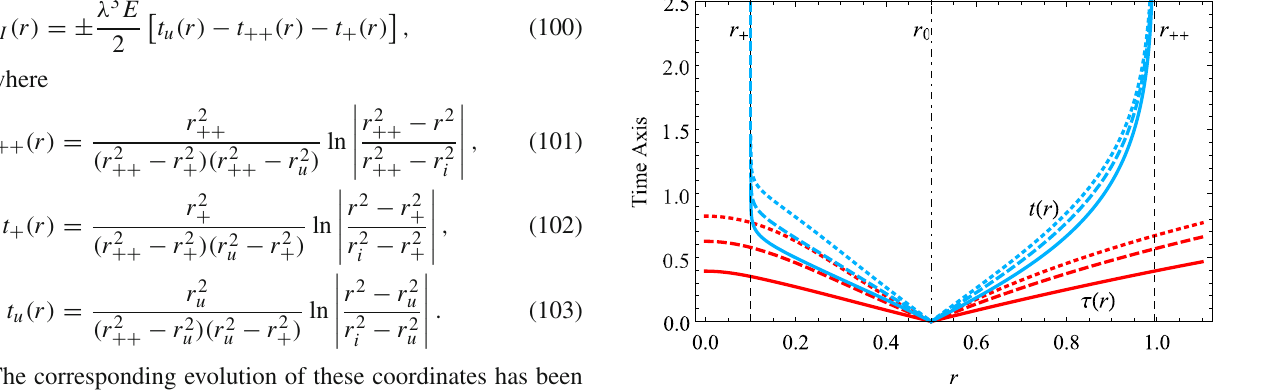
Fig. 14 Plot of the radial capture for particles. With Q = 0 . 2, λ = 1 and ρ 0 = 0 . 5. The way of the behavior of the time parameters are similar to those in the radial scattering. The plots have been done for three different values of E > E u and are classified as dotted: E 2 = 1 < 1 + Q /λ , dashed: E 2 = 1 . 2 = 1 + Q /λ and solid: E 2 = 2 > 1 + Q